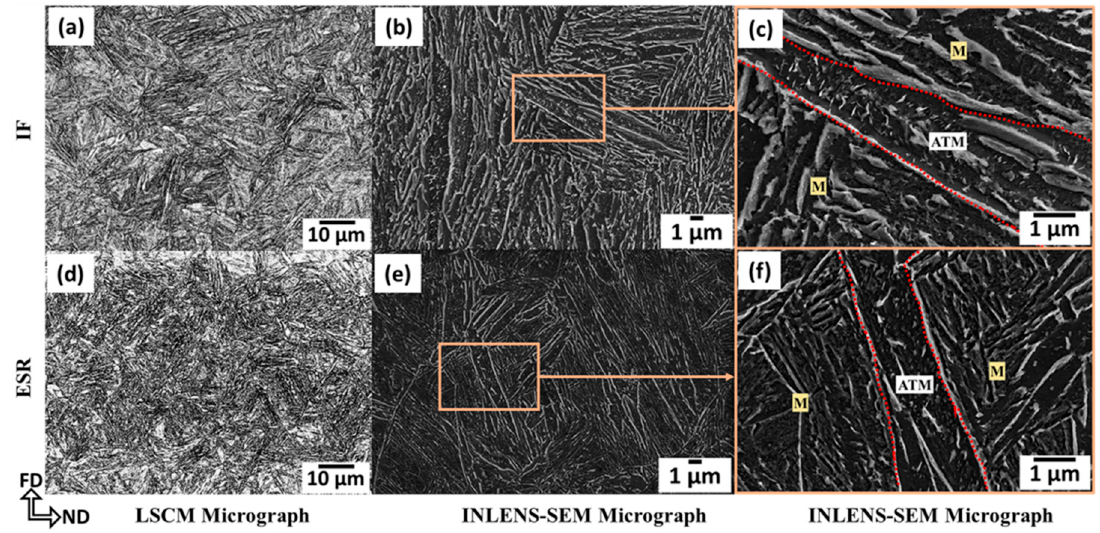
Figure 3. Laser and INLENS-SEM micrographs of UHSS II (IF) without ESR ( a , b, and c ) and with ESR ( d , e, and f ). M: martensite and ATM: auto-tempered martensite.